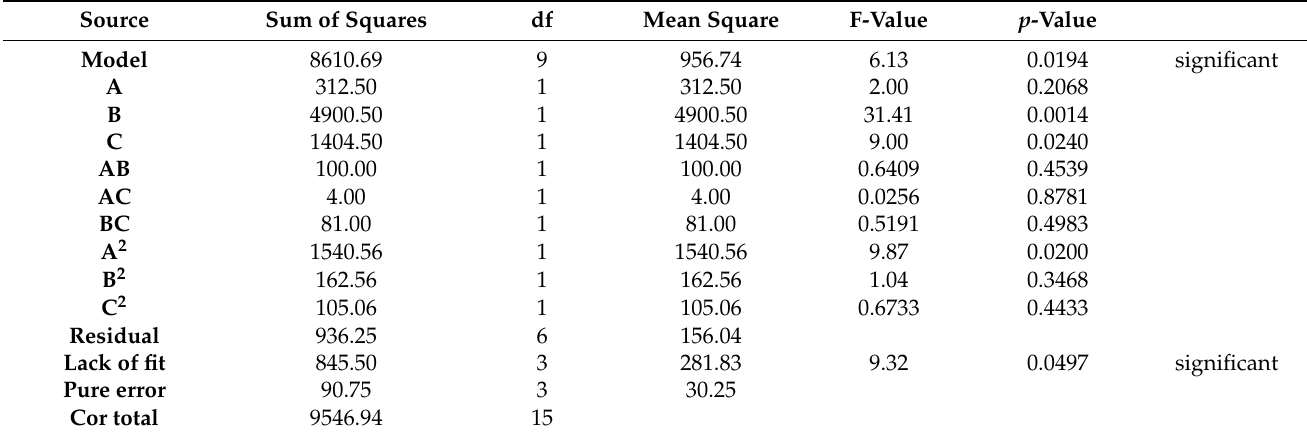
Table 5. ANOVA for the response surface quadratic polynomial model for DCSLM with threshold concentration of D2EHPA.